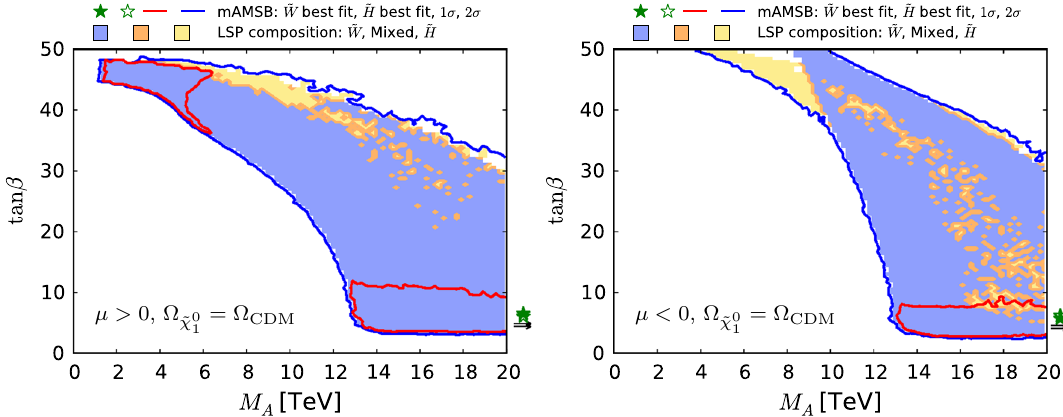
Fig. 11 The ( M A , tan β) planes for μ > 0 ( left panel ) and for μ < 0 tours, and the wino-like (Higgsino-like) (mixed wino–Higgsino) DM ( right panel ), assuming that the ˜ χ 0 contributes all the CDM density. As regions are shaded blue ( yellow ) ( orange 1 previously, the red ( blue ) contours represent the 68% (95%) CL con-